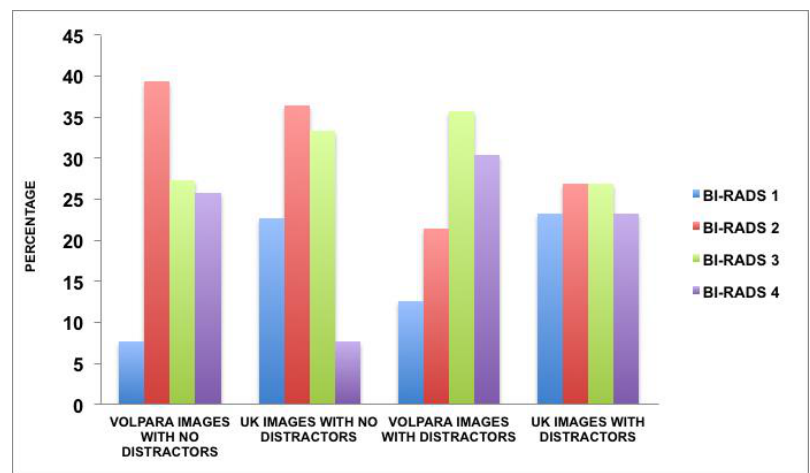
Figure 5. Distribution of the BI-RADS scoring amongst cases with and without distractors for VOLPARA and UK radiologists.